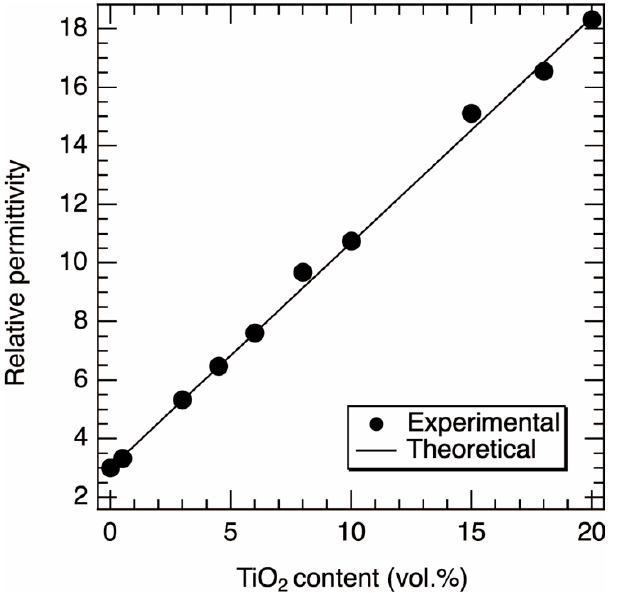
Figure 2. Comparison of theoretical and experimental values of relative permittivity of composite films.